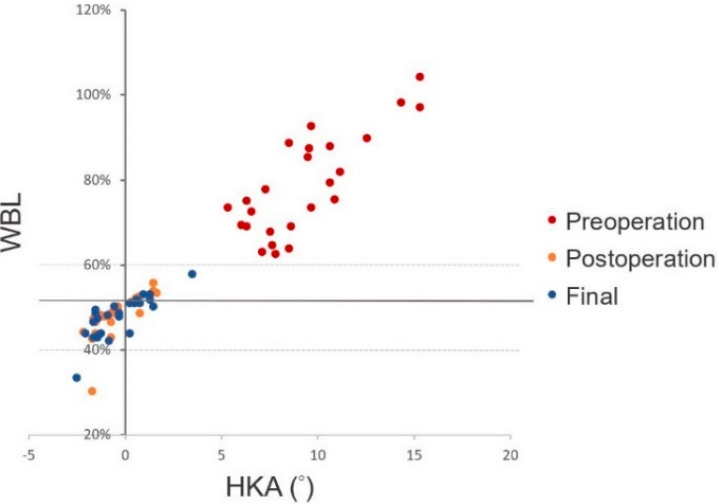
Figure 4. The scatter plot of HKA and WBL ratios of all patients measured preoperatively, 2 days postoperatively, and at the final follow-up. Only one knee (4%) at 2 days postoperatively, and in the final radiographs, fell in the defined range (WBL 50% ± 10%) of outliers of correction.